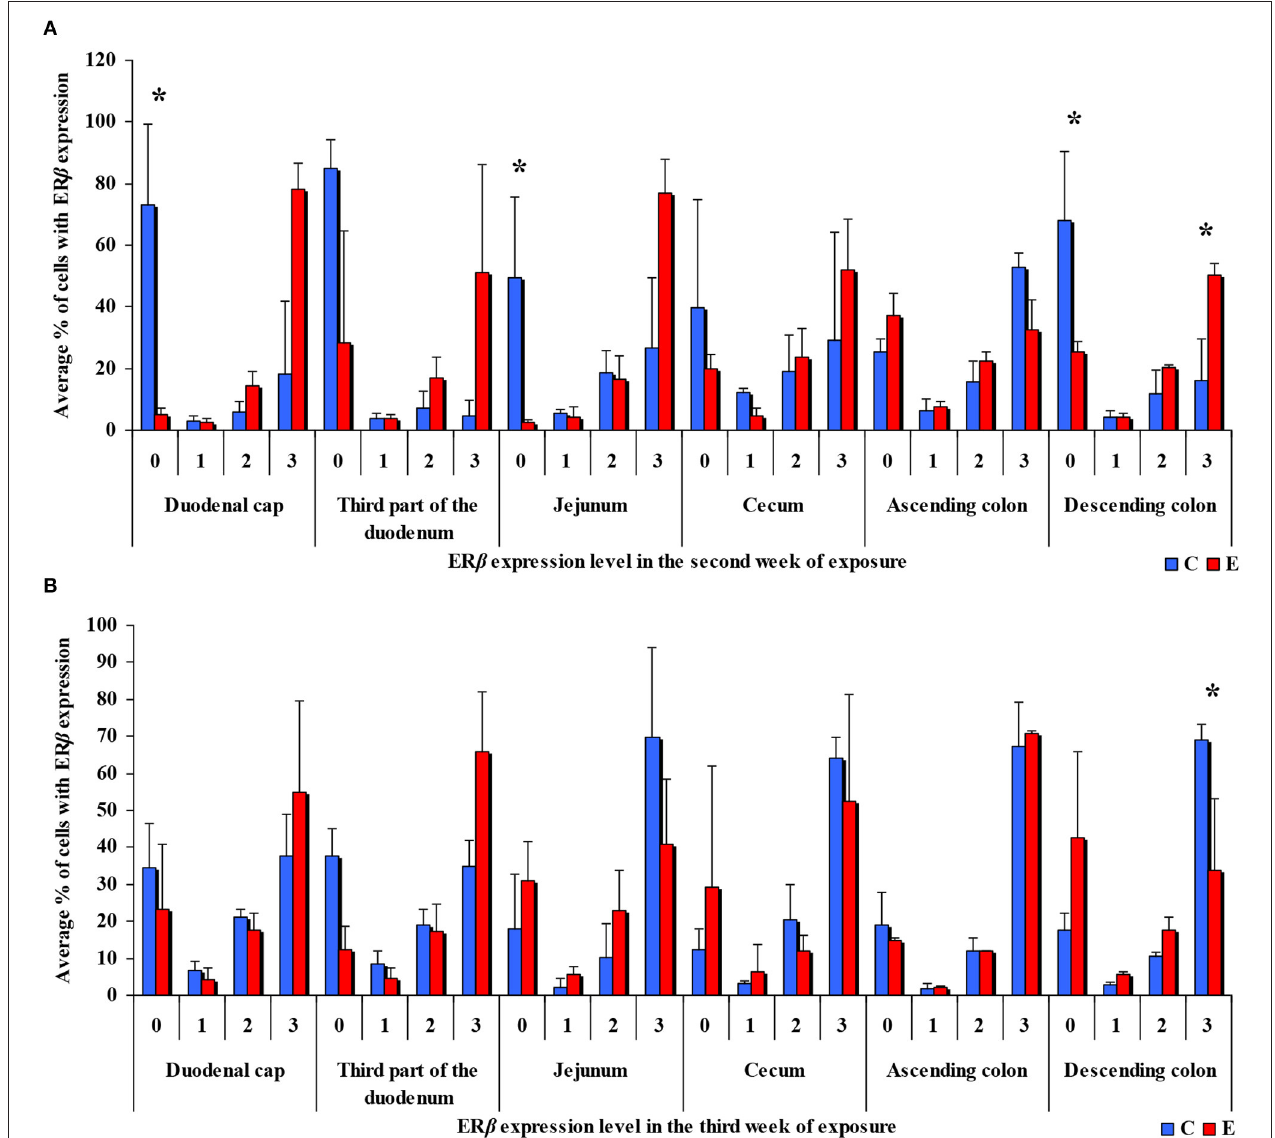
FIGURE 5 | Immunohistochemical expression of ER β (graded on a 4-point scale: negative = 0 points; weak and homogeneous = 1 point; mild or moderate and homogeneous = 2 points; intense or strong and homogeneous = 3 points) in different intestinal segments in selected weeks of exposure: (A) in week II; (B) in week III. ER β expression was presented as mean values ( ± ) and standard deviation (SD) for each sample. * P ≤ 0.05 were compared with the control group.